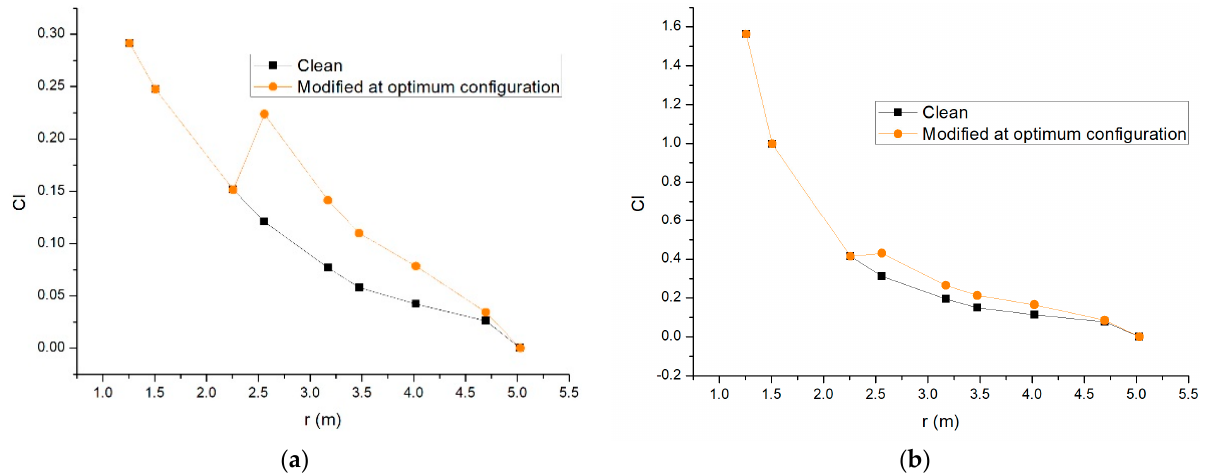
Figure 9. Comparison between lift coefficient vs . radial position for the clean blade and the modified optimum blade of configuration T6. ( a ) V = 5 m/s, ( b ) V = 7